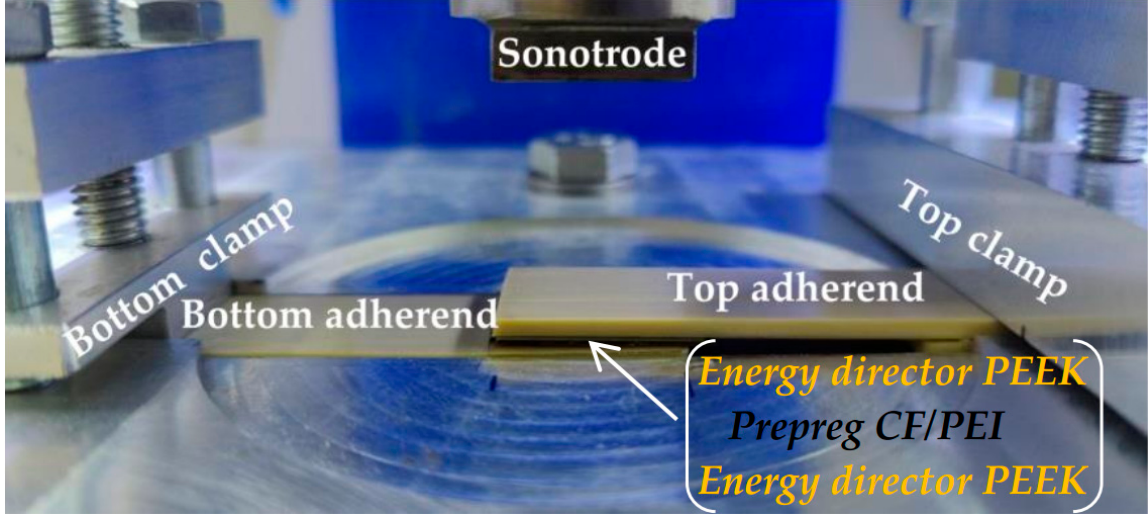
Figure 1. The USW facility.